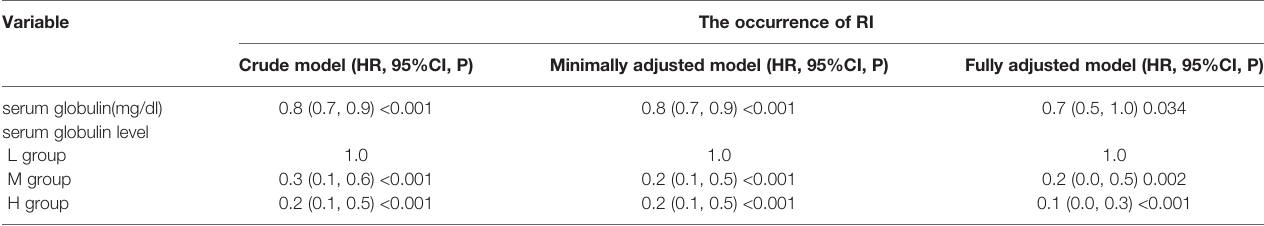
TABLE 2 | Cross-sectional Correlation Analyses between serum globulin level and the presence of RI in different models.